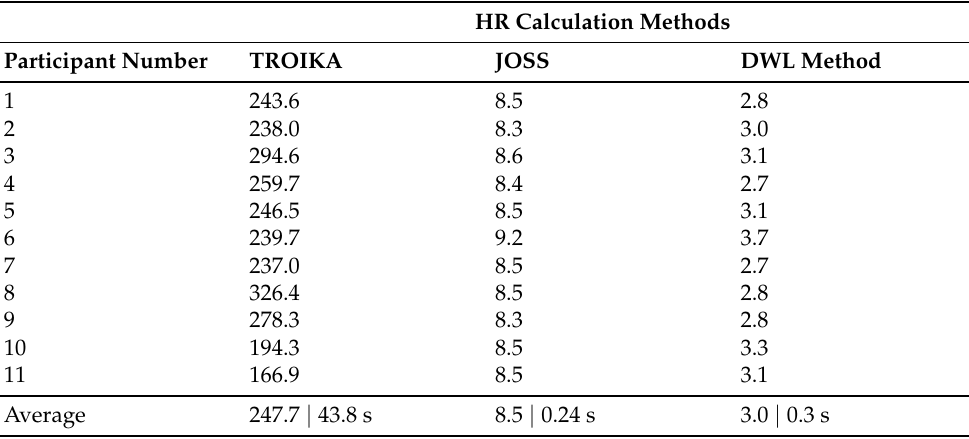
Table 5. CT in seconds for all eleven (11) experimental participants, using DWL, TROIKA, and JOSS. The last row shows the CT average of all eleven (11) participants shown as “mean | standard